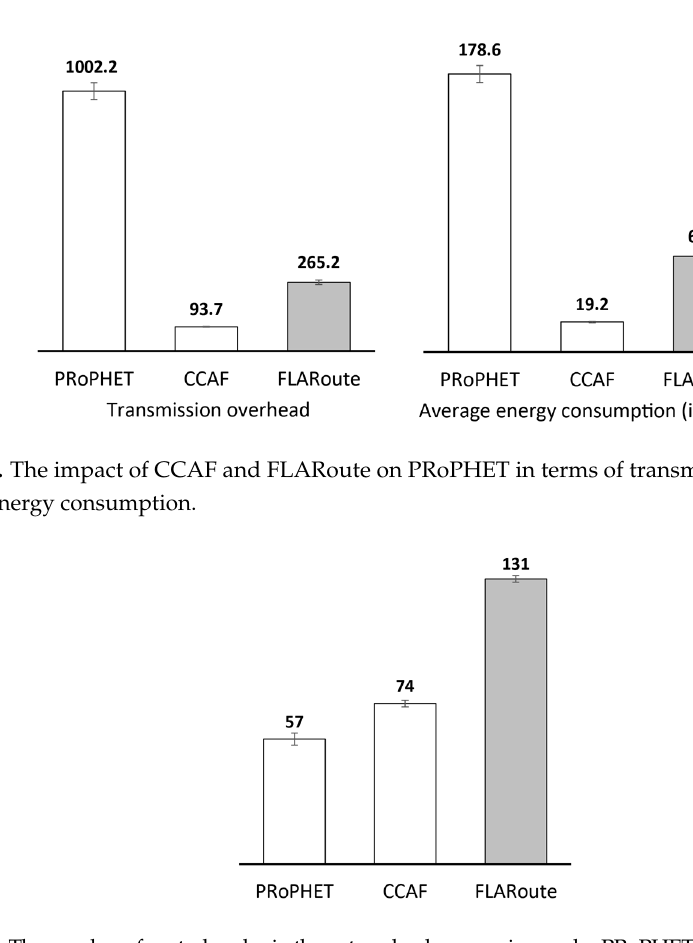
Figure 14. The number of central nodes in the network when running under PRoPHET, CCAF and FLARoute.